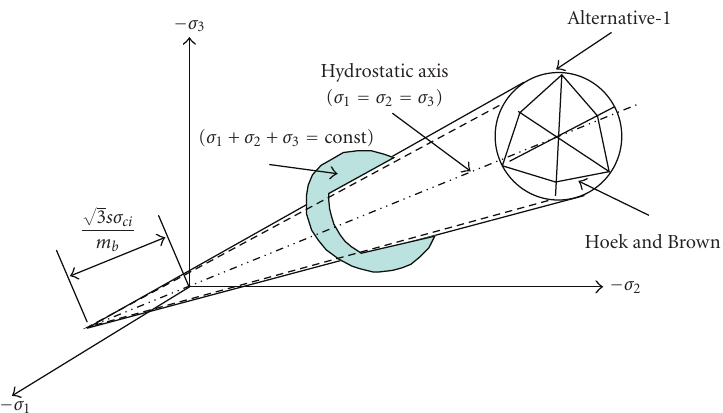
Figure 1: Generalized Hoek and Brown yield surface in principal stress space.